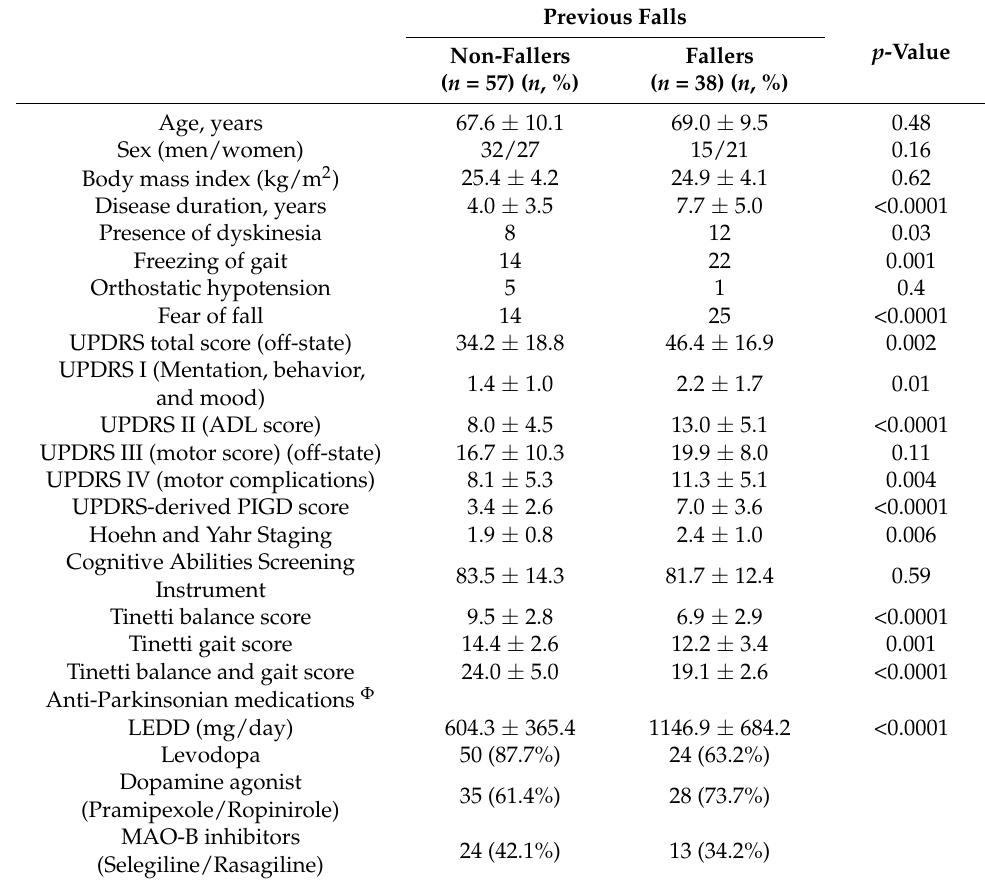
Table 1. Baseline characteristics of